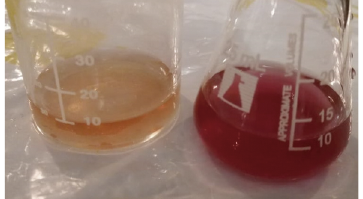
Figure 4. Resulting solution (left) from the reduction of a dil. KMnO medium (right) by the white precipitate obtained from the reduction of CO